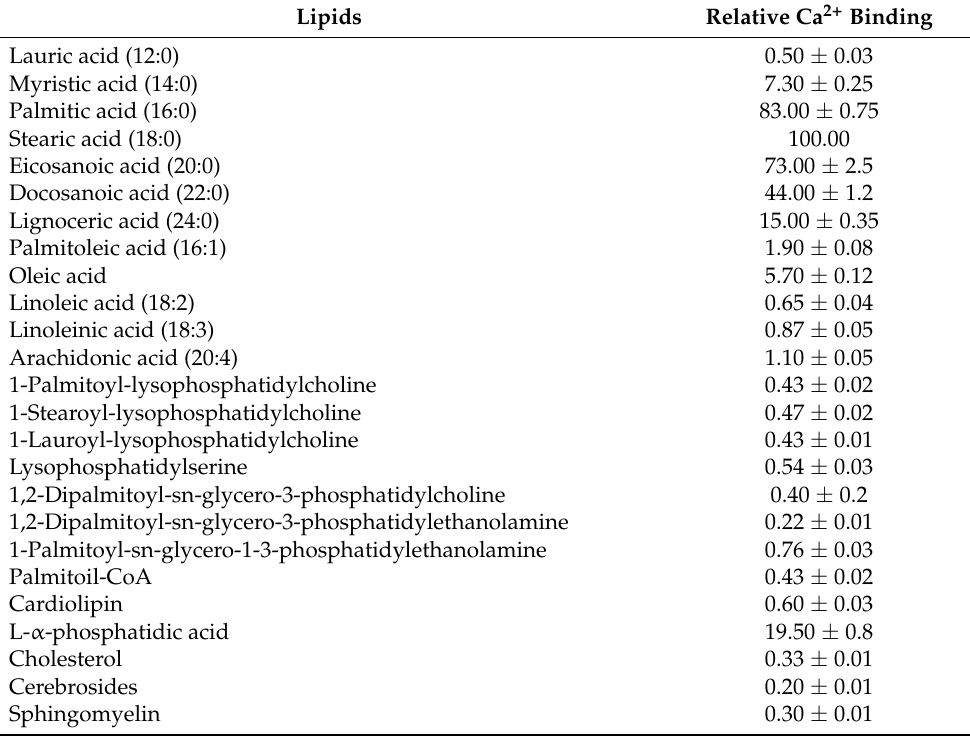
Table 1. Binding of various fatty acids and lipids 1